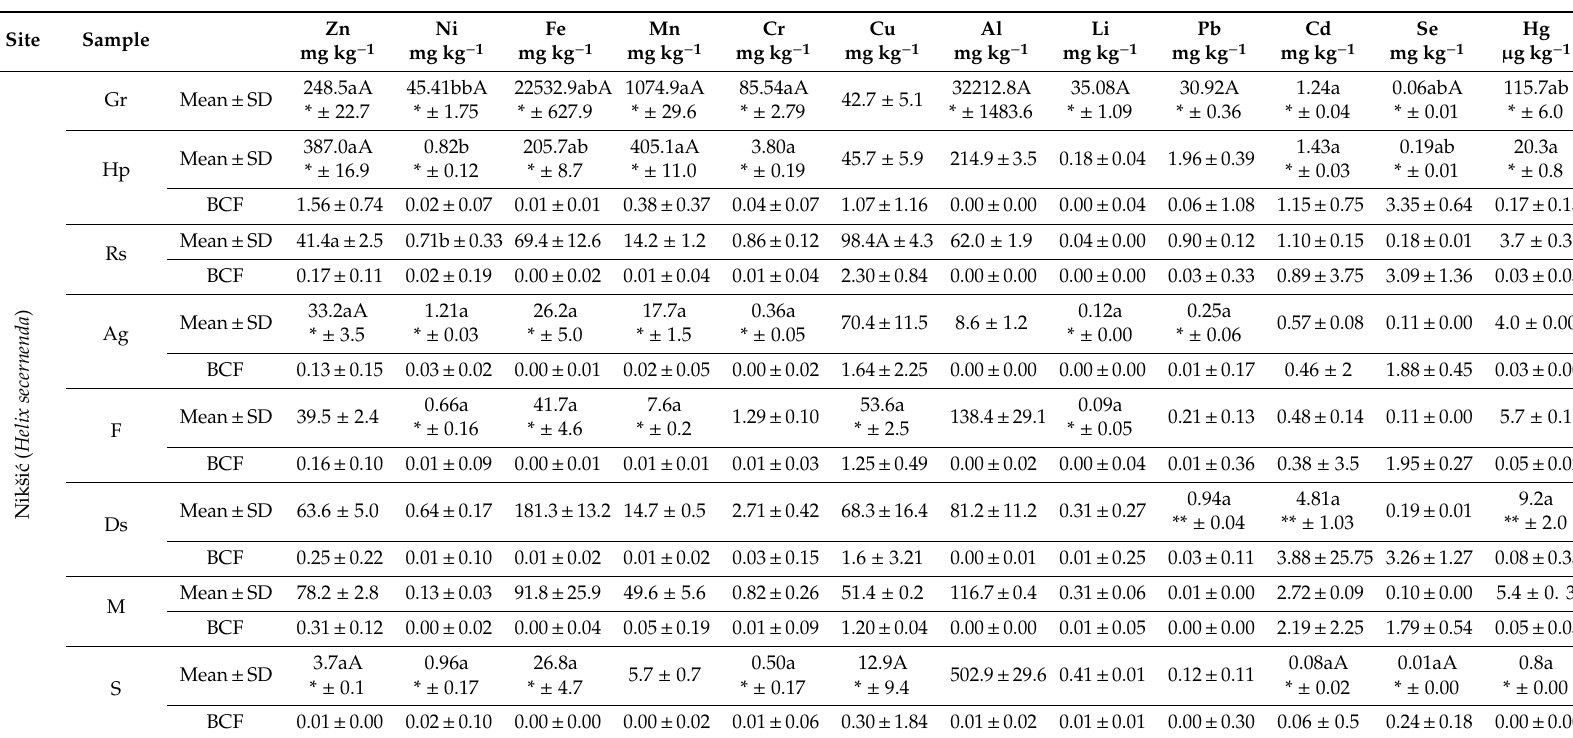
Table 4. Minerals and toxic elements content of the di ff erent snail tissues from the three sampling sites. The concentrations of elements in the ground and snail tissues were expressed as mean ± standard deviation calculated on a dry weight (d.w.) basis. a,b—the mean values marked with small letters di ff er statistically significantly at p ≤ 0.05 horizontally; A—the mean values marked with capital letters di ff er statistically significantly at p ≤ 0.05 vertically. * Tukey’s t -test statistics, **